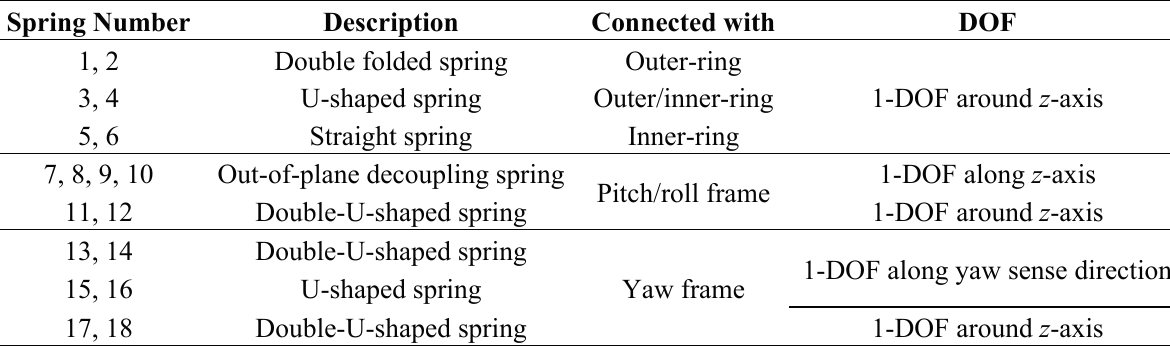
Figure1. Schematic diagram of the triaxial vibratory wheel gyroscope. Table 1. Description of the